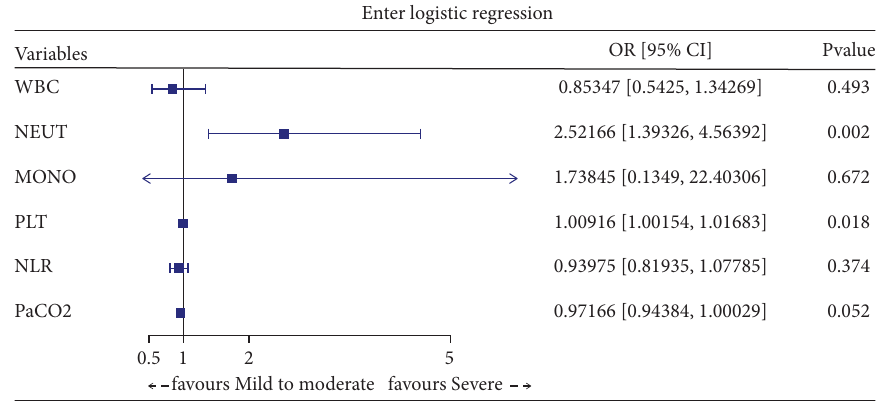
Figure 2: Multivariate logistic regression analysis with enter method.